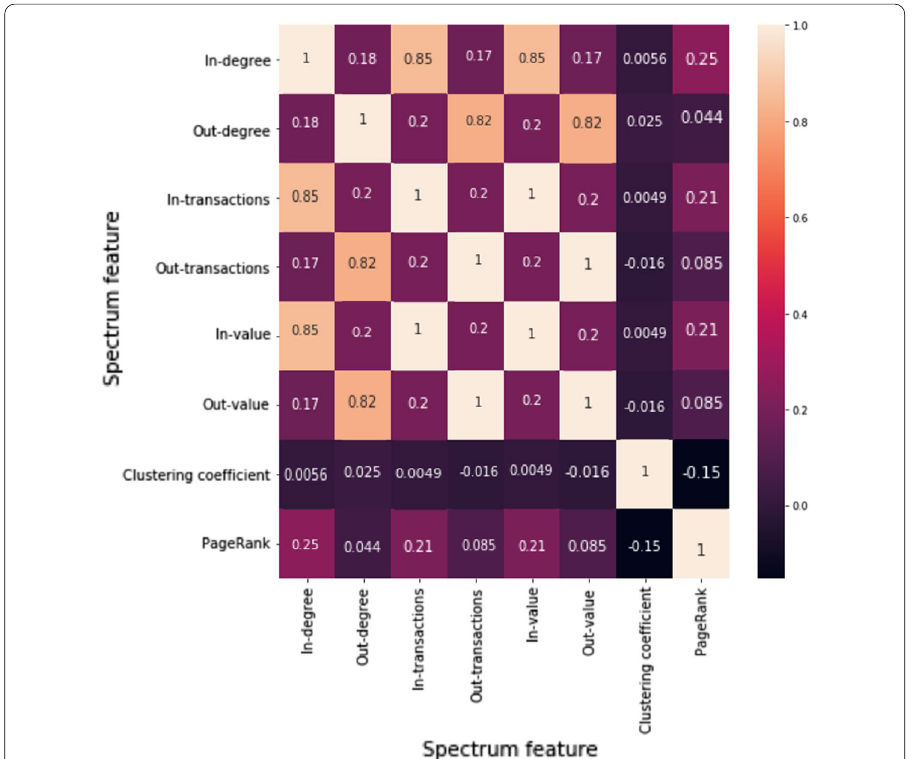
Fig. 3 Correlation matrix for the spectrum features of all the addresses in the training data